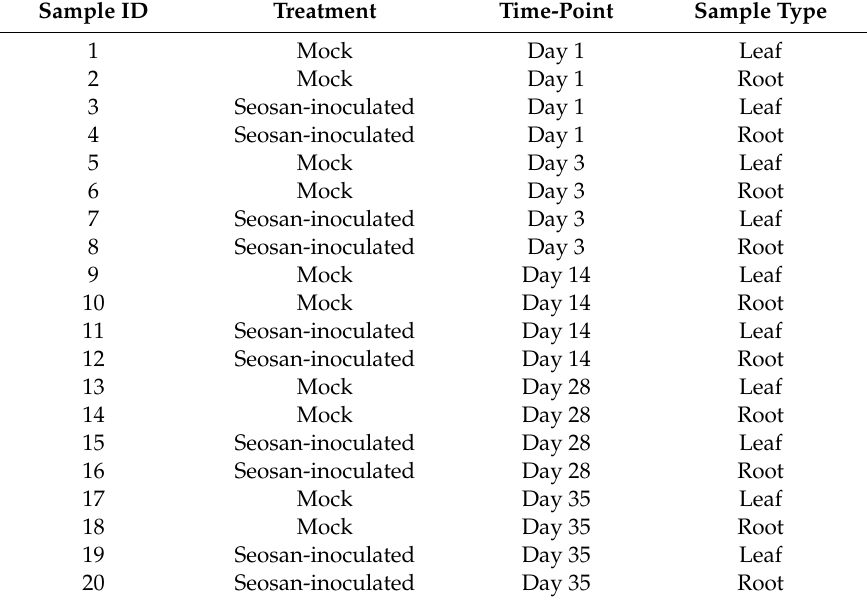
Table 3. Twenty samples collected from Seosan-inoculated and non-inoculated plants at five di ff erent time-points under two di ff erent